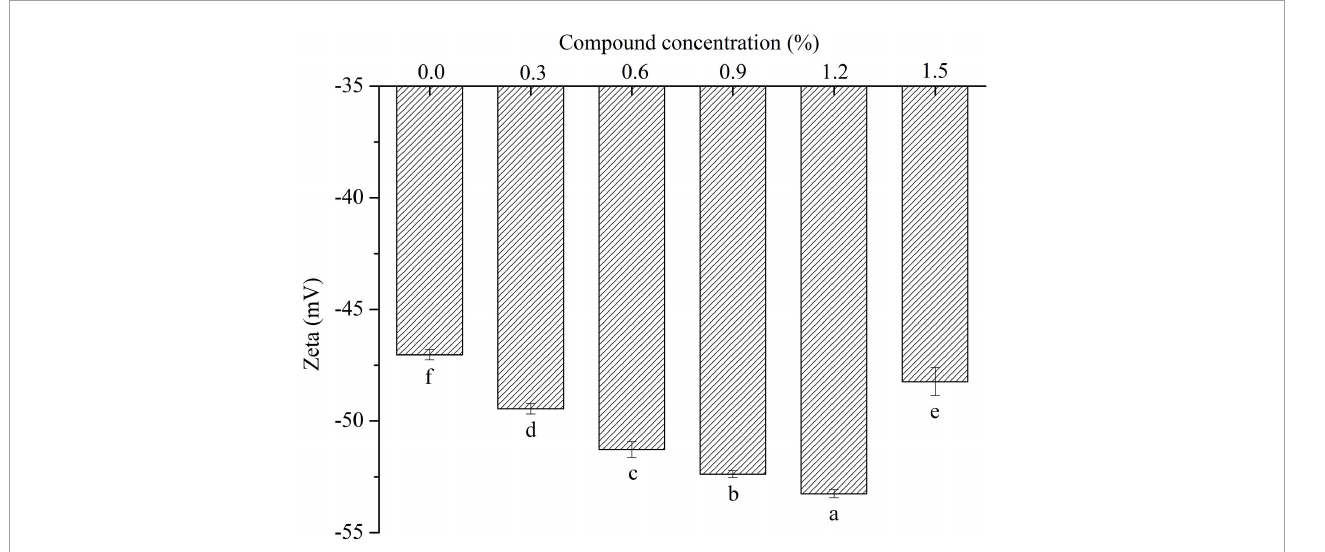
FIGURE5 The zeta potential of the emulsions with different concentrations of compound fibers. The data are expressed as the mean ± standard error. Values with different lowercase letters are significantly different ( P <